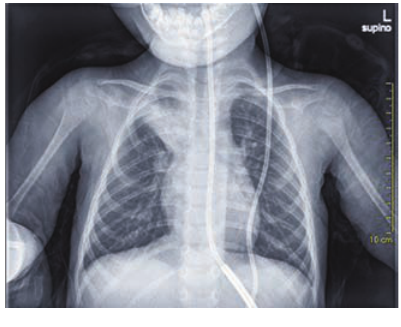
Figure 1. Posteroanterior chest X-ray study performed on admission, showing a right pneumonia.